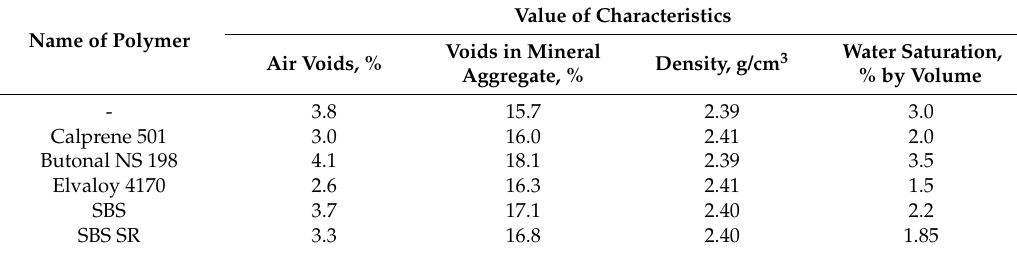
Figure 1. Granulometric curve of mineral part of the stone mastic asphalts. Table 4. Mix design characteristics of the stone mastic